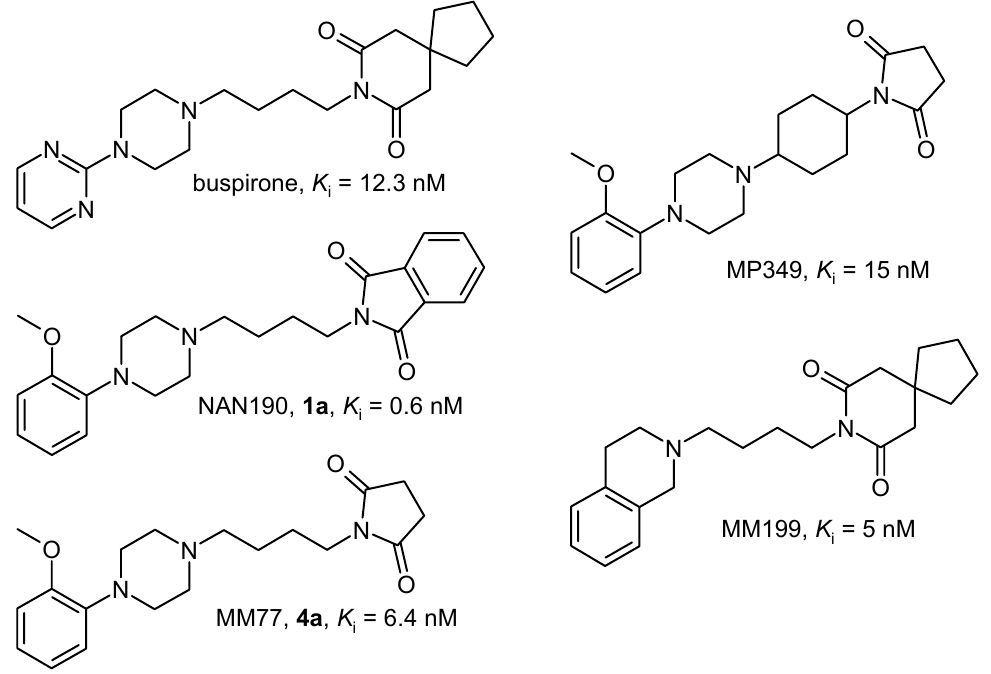
) of the selected 5-HT i